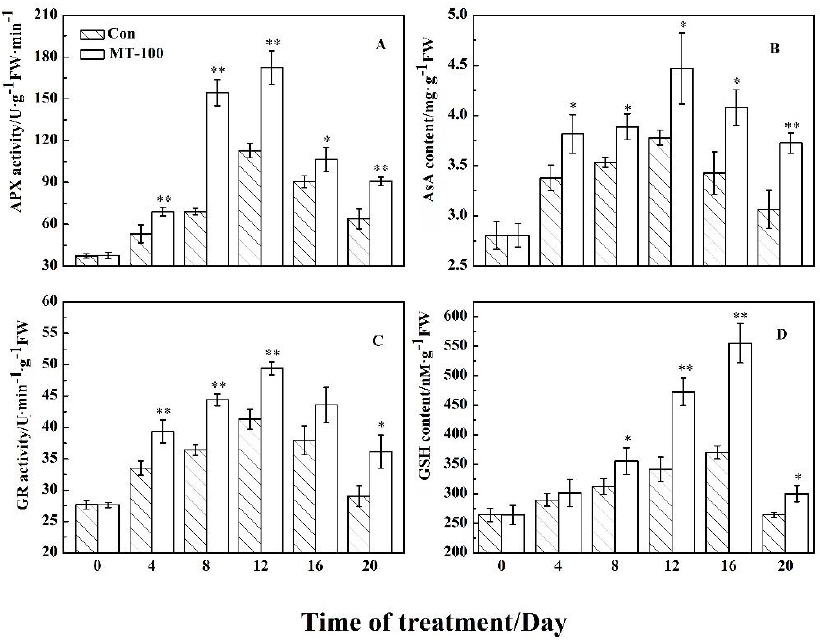
Figure 5. Effects of MT on the content of primary antioxidants and activity of main enzymes involved in AsA-GSH cycle in detached grapevine leaves during dark-induced senescence. ( A ) APX activity. ( B ) AsA content. ( C ) GR activity. ( D ) GSH content. ** and * indicate significant differences at 0.01 and 0.05 levels.